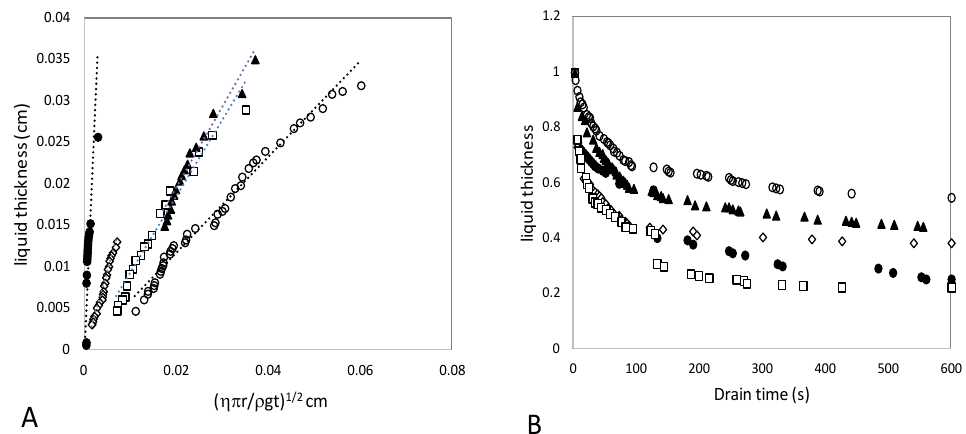
Figure 2. Fennel liquid film thickness dependence on viscosity, height curvature, density, and draining time of SC coating solutions at different concentrations ( A ). Liquid thickness, expressed as ratio between thickness at time t divided by thickness at time zero, vs. draining time for SC coatings at: 4% (●), 8% (◊), 10% (□), 12% ( ▲ ), and 14% ( ○ ) ( B ).